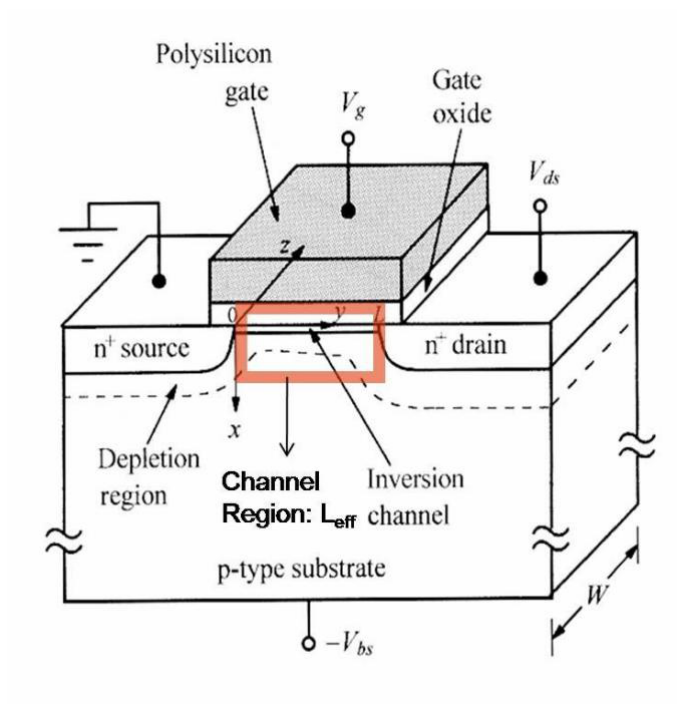
Fig. 5 Metal-oxide-semiconductor field-effect